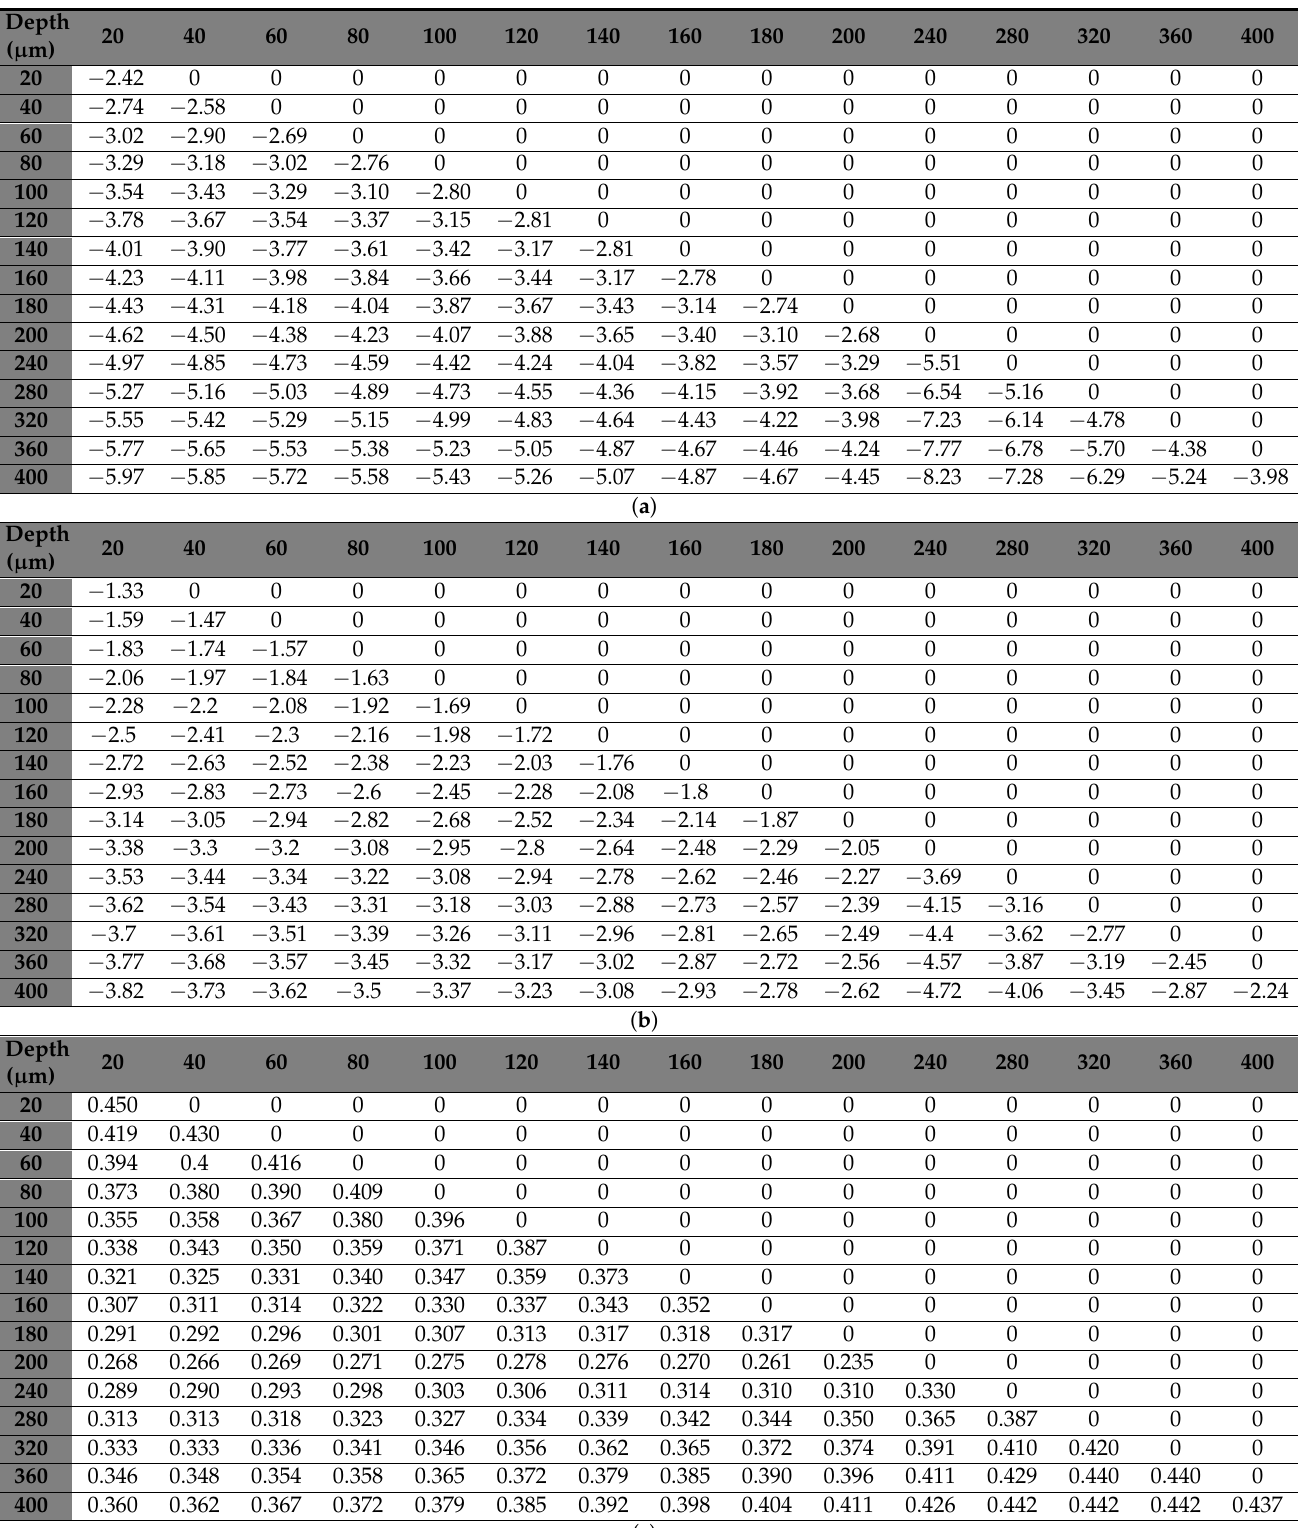
Table 1. Calculated coefficients C 11ij of the unidirectional ( a ) and multidirectional ( b ) CFRP sample and ( c ) the relative difference between both samples in